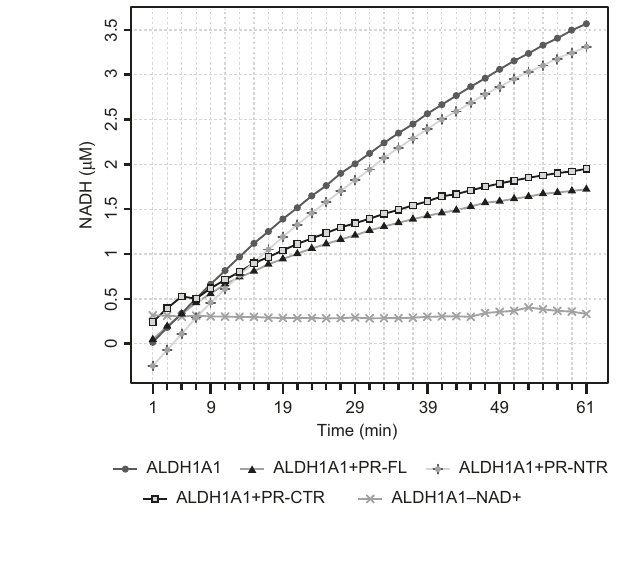
Fig. 4 PRMT3 inhibits the ALDH1A1 activity in vitro. a Puri fi cation of GST- tagged ALDH1A1-FL, GST-tagged PRMT3 full-length protein, GST-tagged N-terminal region of PRMT3, and GST-tagged catalytic domain of PRMT3 proteins. Coomassie-stained gel of puri fi ed GST-tagged ALDH1A1-FL (left panel) and GST-tagged PRMT3 full-length protein (PR-FL), GST-tagged N- terminal region of PRMT3 (PR-NTR), and GST-tagged catalytic domain of PRMT3 proteins (PR-CTR) (right panel). b PRMT3 inhibits the ALDH1A1 activity in vitro. ALDH1A1 activity was measured in the presence and absence of GST-tagged PRMT3 full-length protein or GST-tagged N- terminal region of PRMT3 or GST-tagged catalytic domain of PRMT3.